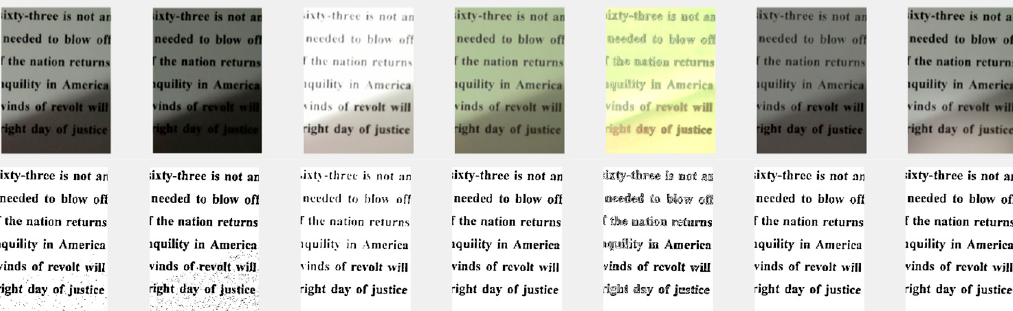
Figure 12. One well-exposed region in well-exposed images. From left to right: well-exposed image, under-exposed image, over-exposed image, ReinhardTMO HDR image, DurandTMO HDR image, Goshtashy fusion, and the Merten fusion method. The images in the top row correspond to RGB images and the images in the bottom row correspond to binary images.